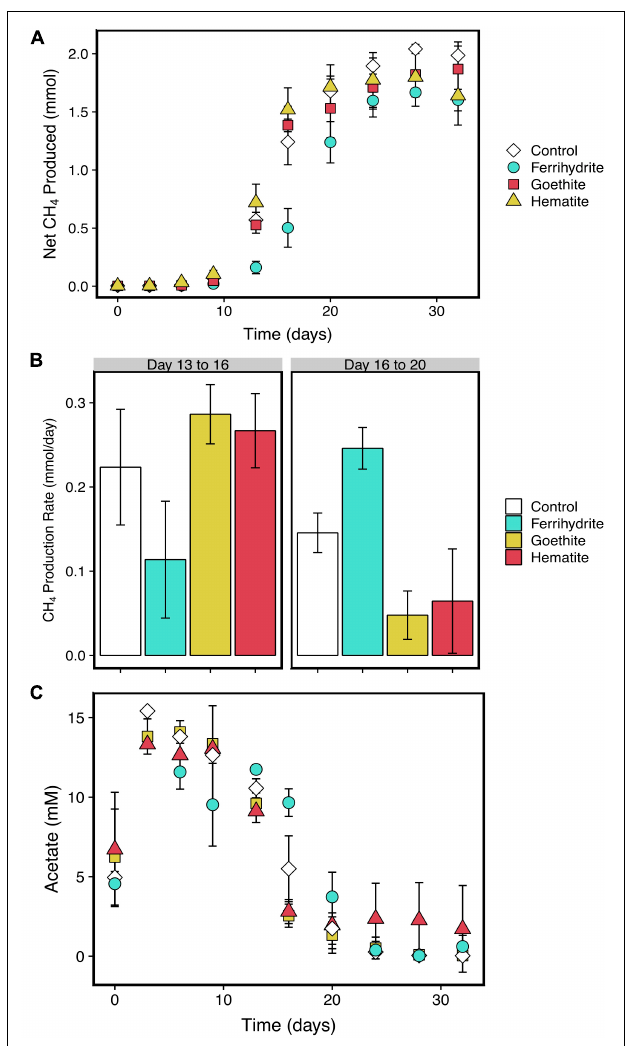
FIGURE 2 | Net methane production in the presence of each mineral or Fe-free control (A) and average daily rates of methane production from Days 13 to 16 and Days 16 to 20, which correspond to maximum measured methane production rates for hematite, goethite, and control; and ferrihydrite incubations, respectively (B) . Acetate concentrations over time are shown in (C) . Error bars in both panels are standard deviations of three replicates. Points without error bars have standard deviations smaller than the